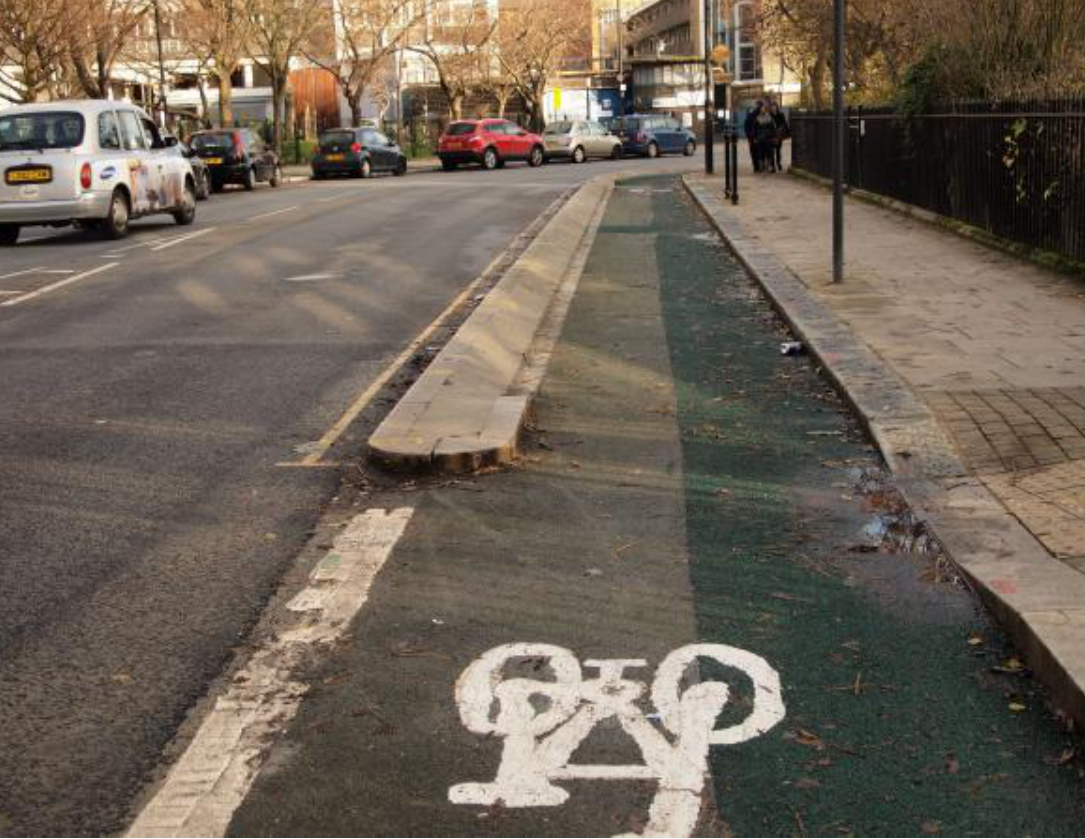
Figure Apx.5. Kerb